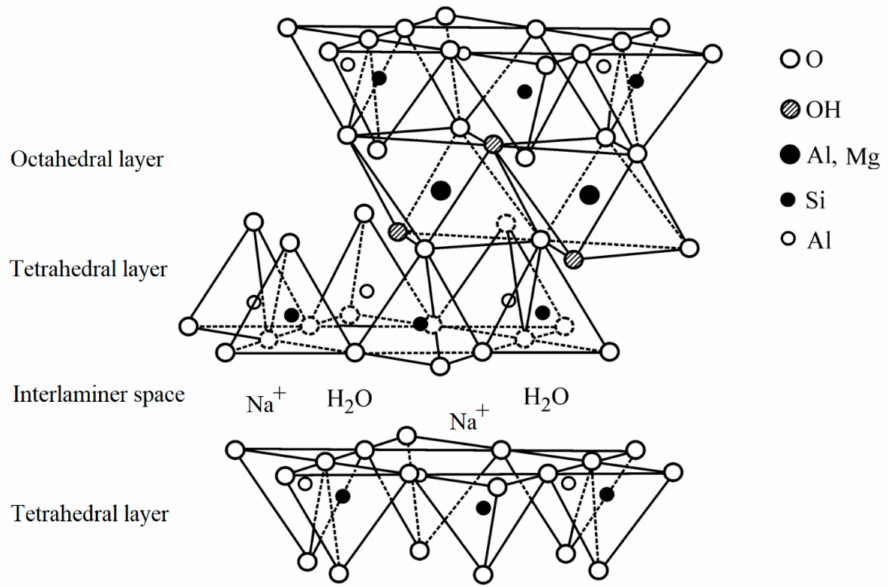
Figure 1. Structural model of sodium montmorillonite Na 0.4 (Al 1.6 Mg 0.4 )Si 4 O 10 (OH) 2 showing ex- changeable cations and water molecules in the interlaminar space